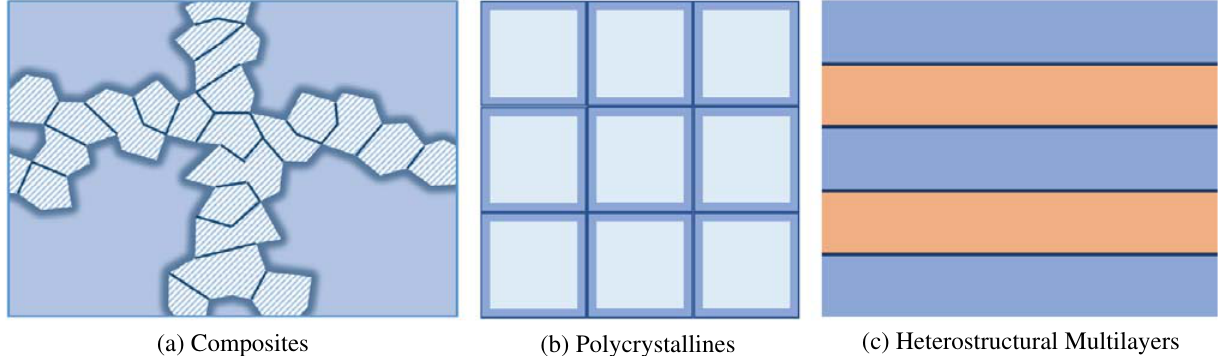
Fig. 2. Typical space charge layer situations of (a) composites; (b) polycrystallines; (c) heterostructural